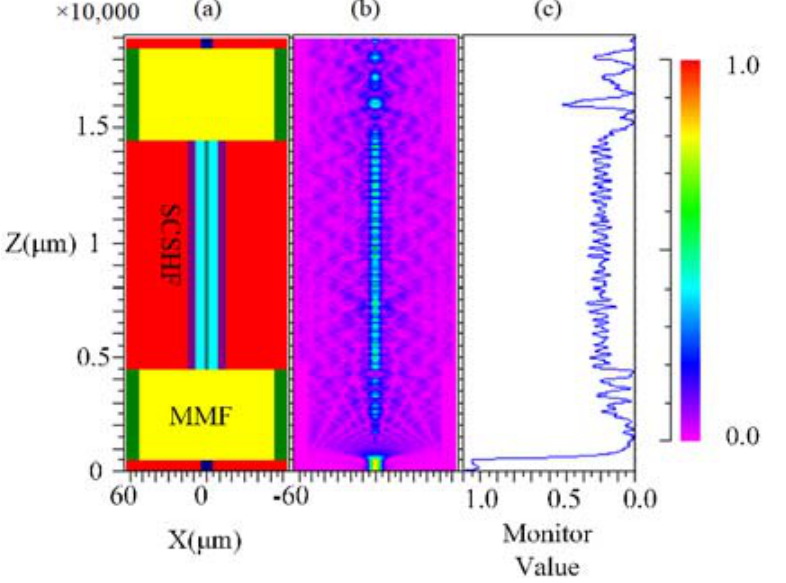
Figure 5. Transmitted spectra of the sensor with different lengths of SCSHF.